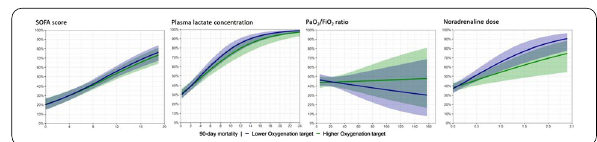
Fig. 1.Conditional effect plots illustrating the potential interaction between treatment allocation and 90-day all-cause mortality on the continuous scale. The values of the individual parameters of interest were plotted on the X-axes; the probabilities of mortality were plotted on the Y-axes. Conclusion. In this secondary Bayesian analysis of the HOT-ICU trial, the adjusted RR for 90-day all-cause mortality, when comparing a lower and a higher oxygenation target, was with 95%